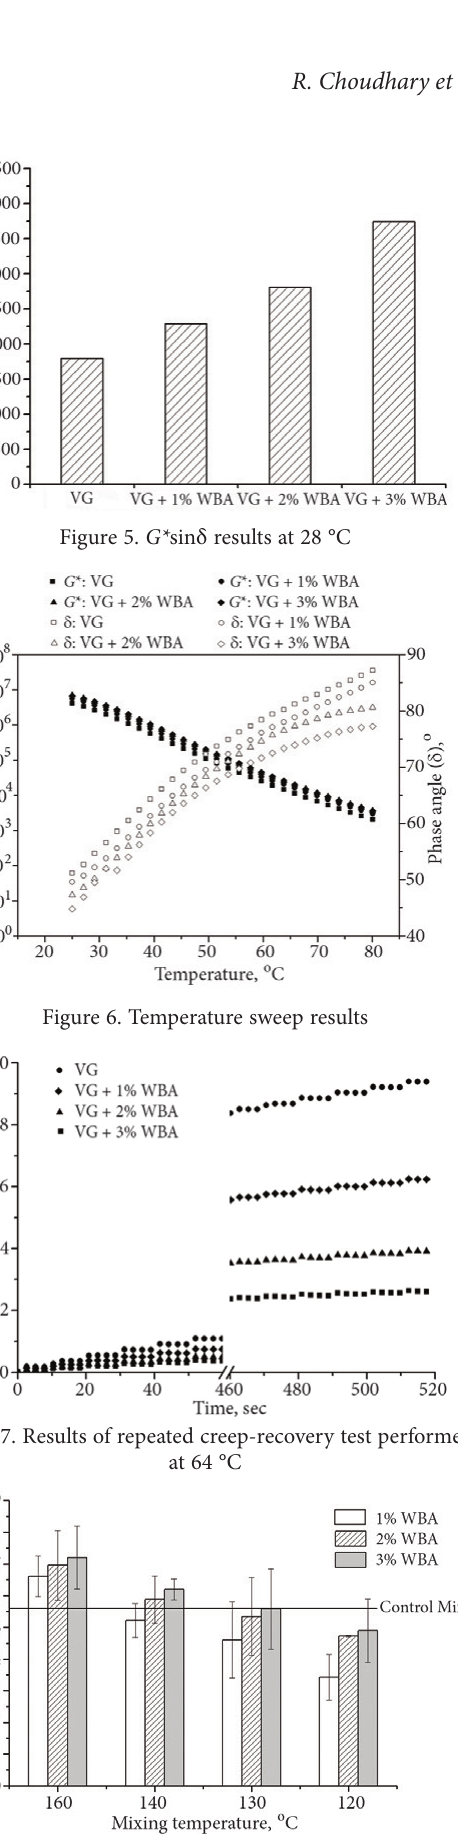
Figure 8. The bulk density of WMA